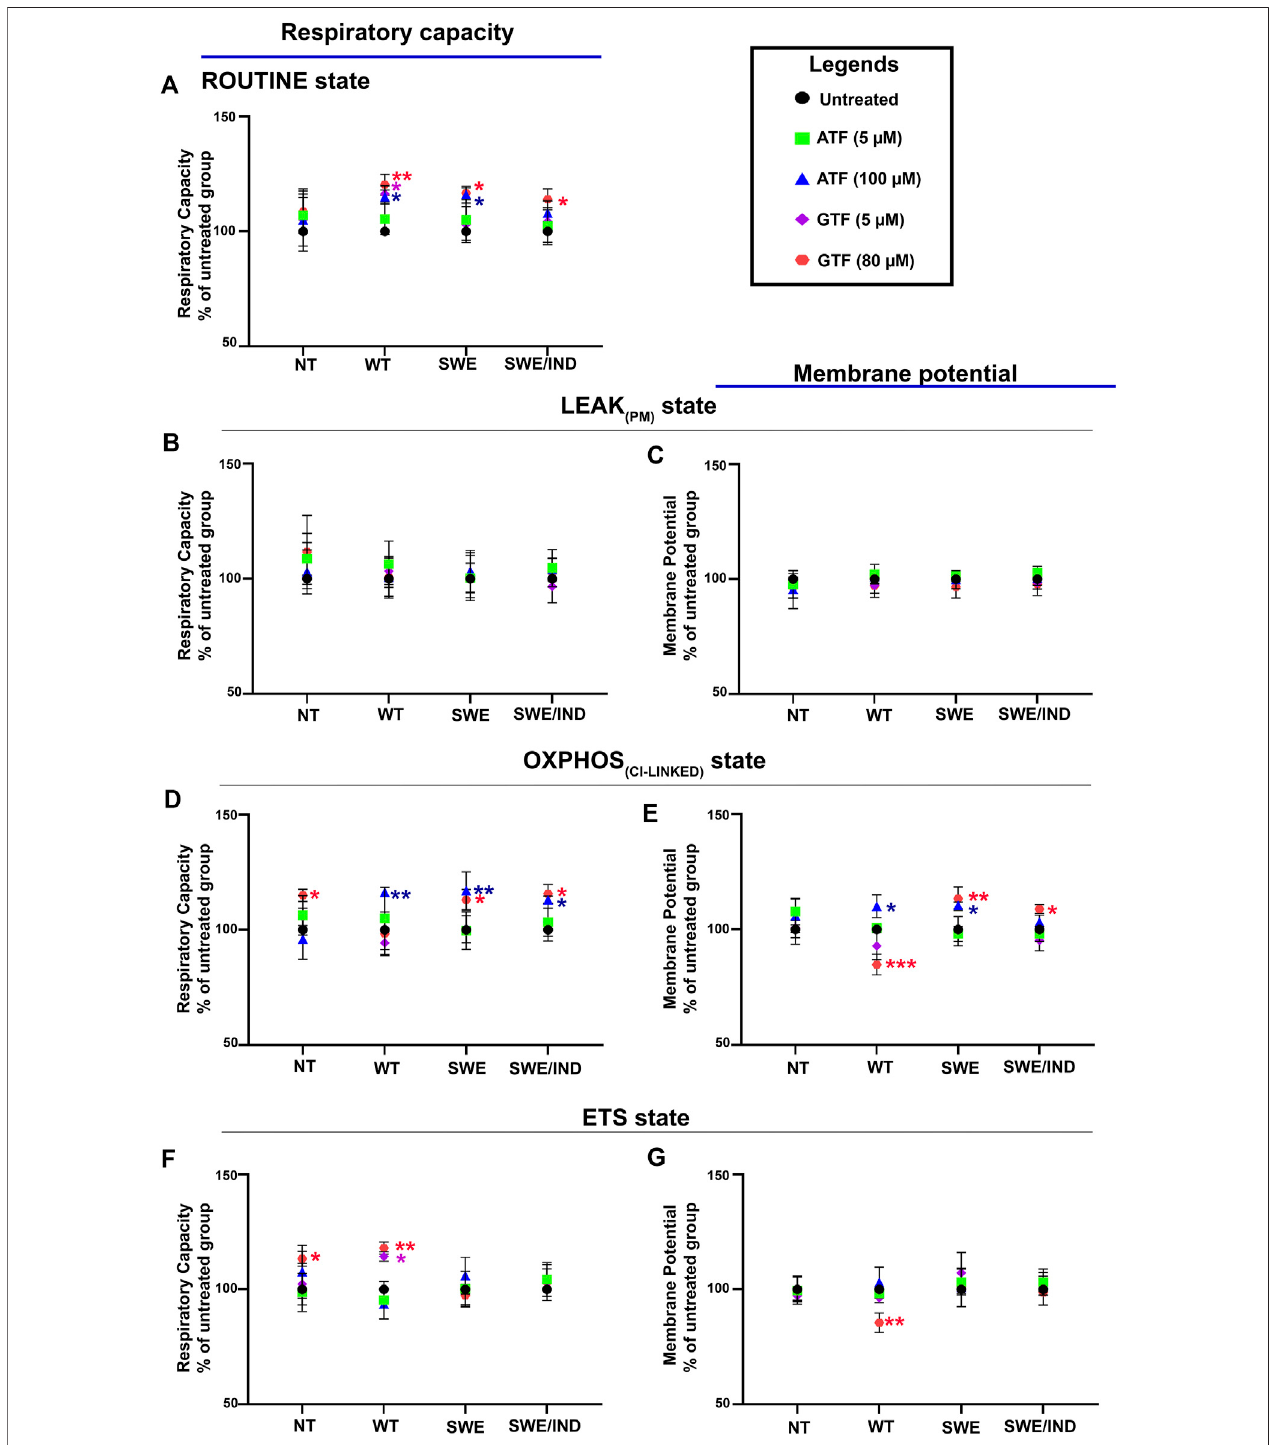
FIGURE 3 | Effects of ATF and GTF treatment on the mitochondrial respiratory capacity and membrane potential in nontransfected SH-SY5Y cells (NT) and cells overexpressing different types of APP(WT, Swe,and Swe/Ind) expressed as %of untreated group in the respective type of cells at (A) ROUTINE, (B, C) LEAK PM , (D, E) OXPHOS CI-LINKED and (F, G) ETS. *: p < 0.05, **: p < 0.01, ***: p < 0.001. Data are expressed as the mean ± SD, (N (cid:1) 3).